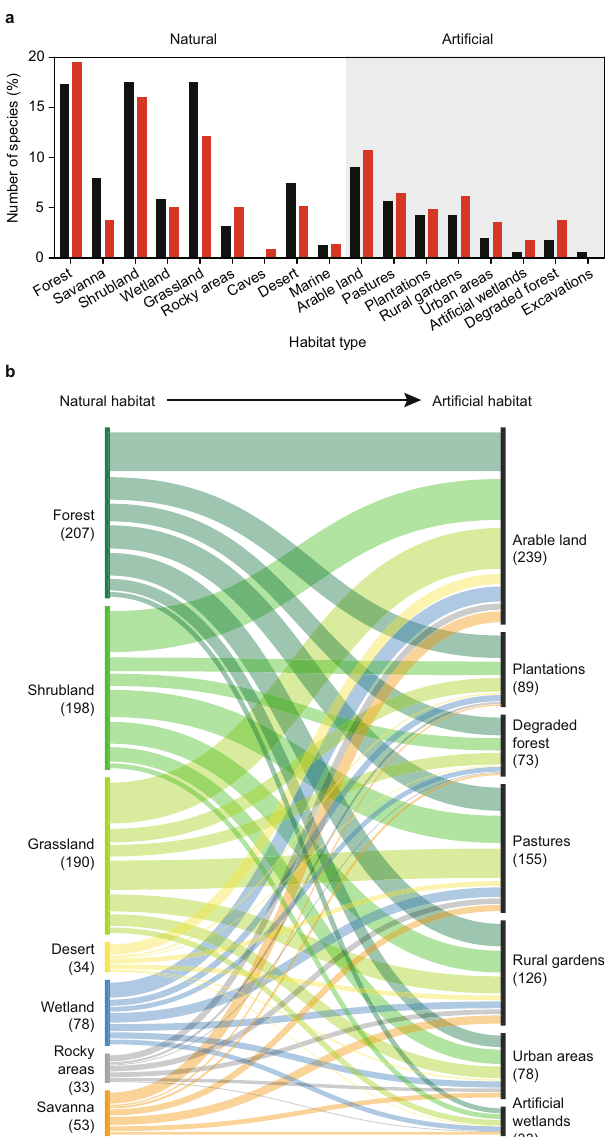
Fig. 4 | Habitat types occupied by rodents. a Percentage of non-reservoir (black bars; n =154) and reservoir rodents (red bars; n =282), respectively, occurring in natural and arti fi cial (shaded) habitats. b Habitat generalism of reservoir rodents. Reservoir rodents occurring in natural habitats potentially move into arti fi cial habitats, e.g., during periods of high population density or when natural habitat is degraded. Thickness of curves represents number of rodents shared between natural and arti fi cial